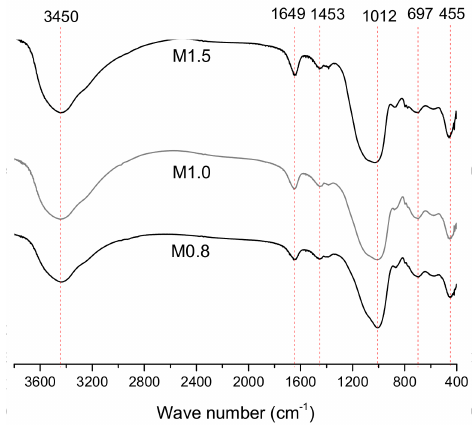
Figure 20. FTIR spectra of 3-day geopolymer